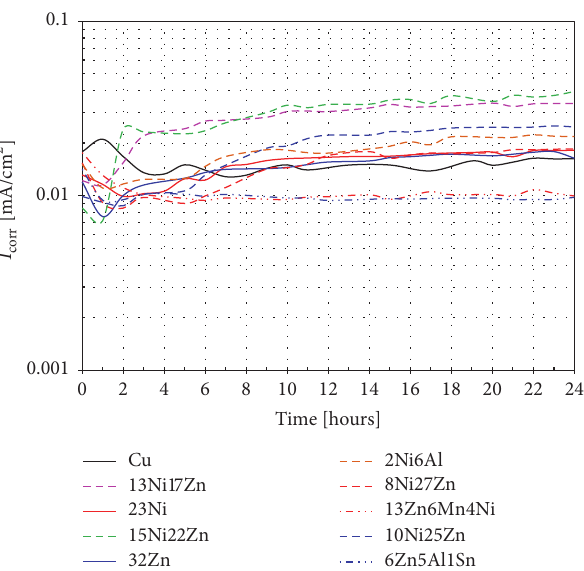
Figure 4: Change of 𝐼 corr values with time for Cu-based coins evaluated in artificial sweat at 37 ∘